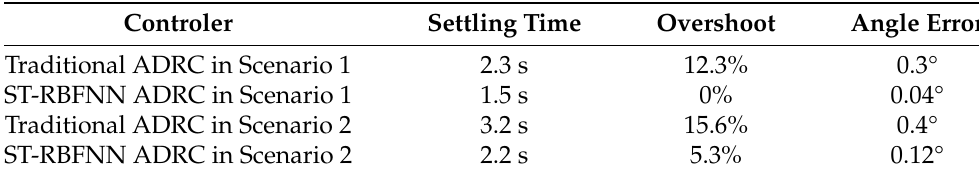
Figure 10. Flight attitude when external interference occurred in Scenario 2. Table 2. Controller performance